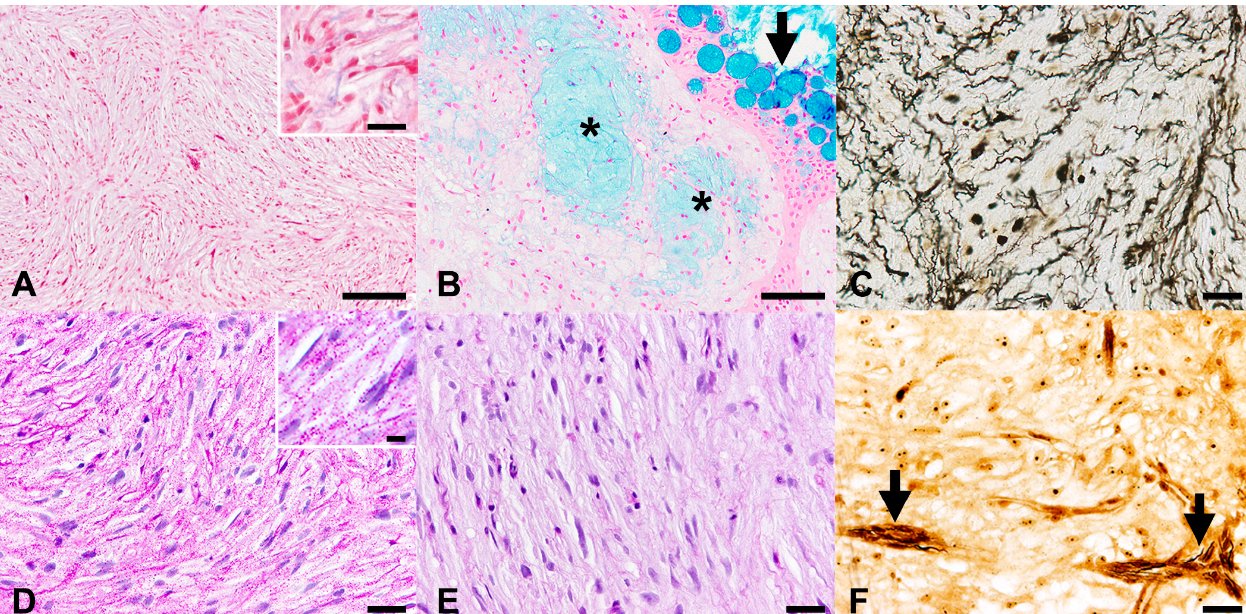
Figure 2. Atypical neurofibroma, skin, goldfish. ( A ) Case 6: Lack of magenta staining of tumor cells, excluding muscular cells as the eventual origin of the neoplasm. Presence of low numbers of collagen fibers (blue) within the tumors (insert). Azan trichrome stain. ( B ) Case 4: Presence of interstitial deposition of glycosaminoglycans or mucins (asterisks) within the tumors. Epidermal goblet cells served as internal positive controls (arrow). Alcian blue stain (pH 2.5). ( C ) Case 6: Scattered to disseminated, single, wrinkling, short fibrils, consistent with basement membrane fragments. Gomori’s reticulin stain. ( D , E ) Case 6. ( D ) Presence of numerous PAS-positive granules within neoplastic cells (insert), which disappeared after diastase treatment ( E ), suggestive of glycogen granules. PAS ( D ) and PAS-diastase ( E ) stain. ( F ) Case 2: Presence of silver-impregnated thin fibers in two of the nodules (arrows), suggestive of axonal elements. Bielschowsky stain. Scale bars 100 µm (A,B), 20 µm (A insert, C,D,E,F), 10 µm (D insert).